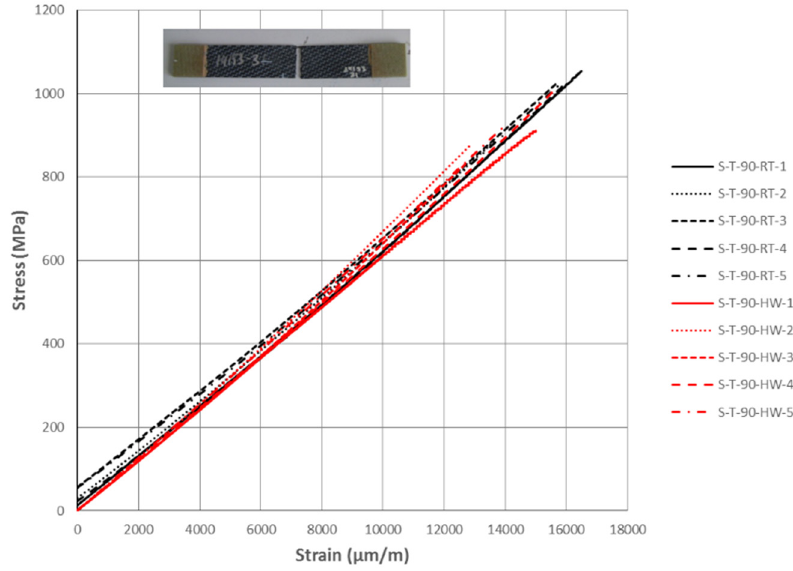
Figure 3. Static tension for weft-directional laminate: stress–strain data and characteristic failure mode.